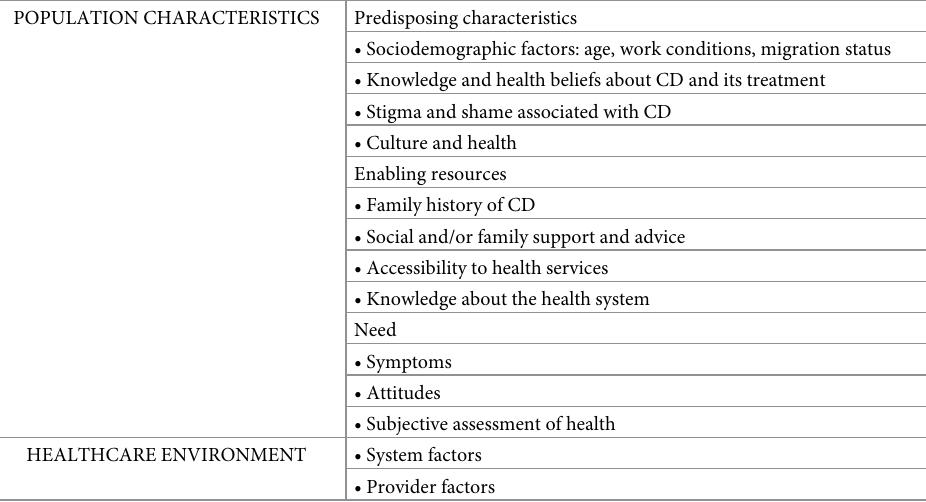
Table 4. Themes and subthemes according to Andersen’s Health Behavioural